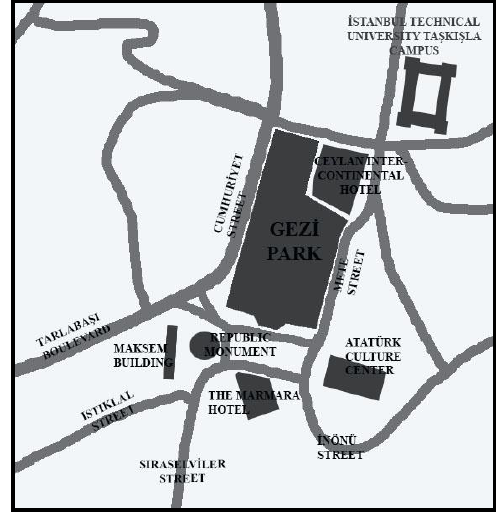
Figure 2. Taksim Square and Gezi Park, map reproduced